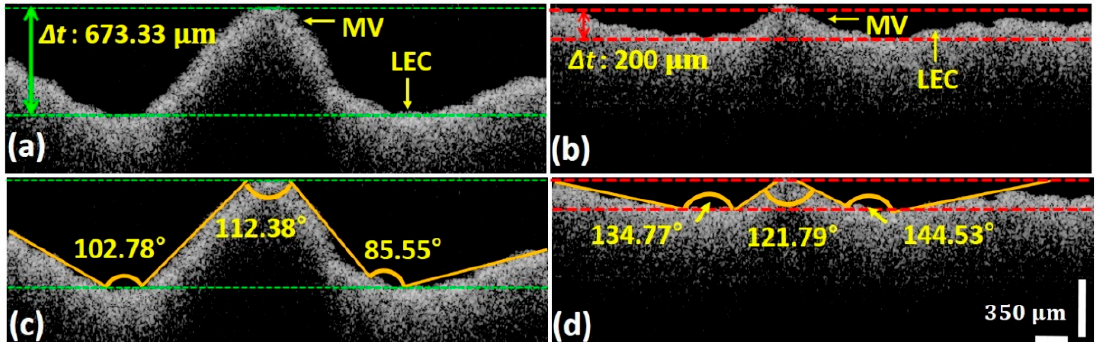
Figure 7. 2D-OCT image based thickness and mid-vein angular comparison between healthy and abnormal rice leaf specimens. ( a , c ) Healthy leaf specimen. ( b , d ) Abnormal specimen. ∆ t : thickness between lower epidermis cells and lower mid-vein of both healthy and abnormal specimens. MV: mid-vein; LEC: lower epidermis cells.